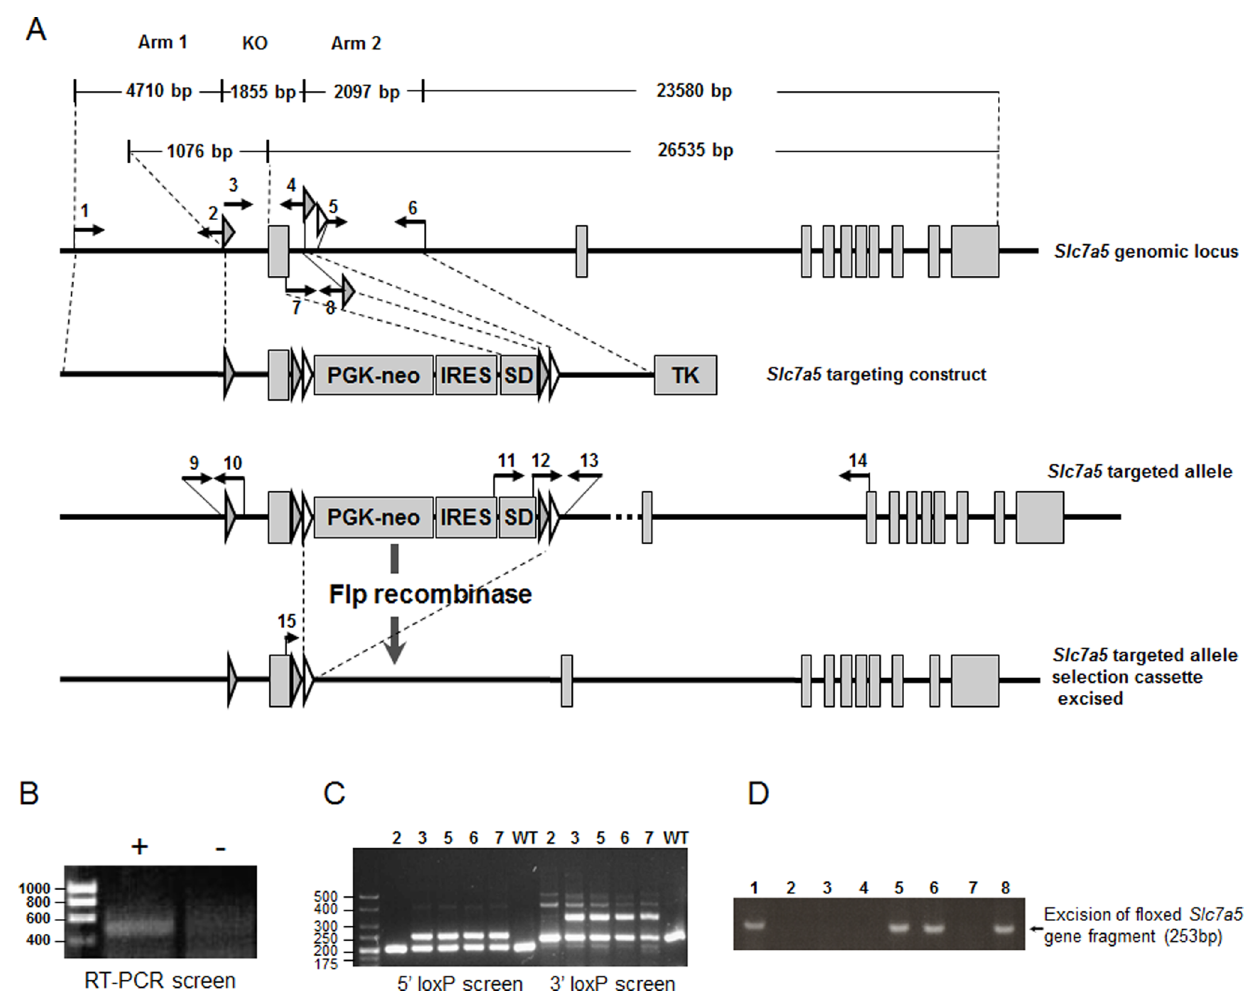
Figure 1. Slc7a5- Flox gene construct and mouse genotyping scheme. (A) Graphical representation of the Slc7a5 -Flox construct used to generate the chimera. Primer locations used for vector assembly and genotyping are indicated and primer sequences shown in Table 1. LoxP sites (grey-filled triangles), FRT sites (white-filled triangles), phosphoglucokinase (PGK) promoter-driven neomycin-resistance gene (PGK-neo) and thymidine kinase gene (TK) are shown. The splice donor (SD) was incorporated into the targeting construct to allow correct splicing of the transcript generated from the PGK promoter only if the targeting construct is inserted within an intron (see B). (B) to (D) Representative PCR genotyping results. (B) RT-PCR screen of RNA from mouse embryonic stem cells using 11–14 primer pair, a 500 bp product would indicate correct joining of the exonic sequence from the splice donor with exon3 of Slc7a5 . Gel shows RT-PCR for a positive ES cell population ( + ) or control cells (–). (C) Genotyping PCR for the 5 9 loxP site using DNA from C57Bl/6 (WT) or a mixed litter of wild-type (2) and heterozygous Slc7a5 Flox Neo ( + / 2 ) (3, 5, 6, 7) mice as a template resulted in either a product of 202 bp or products of 202 and 250 bp, respectively using the 9–10 primer pair. For 3 9 loxP site genotyping, PCR using primer pair 12–13 (note primer 12 is duplicated in SD) generated a 230 bp product from wild-type samples or products of 230 and 318 bp from heterozygotes. (D) PCR analysis of genomic DNA from a single mixed litter of heterozygous Slc7a5 -Flox (2,3,4,7) and Slc7a5 + / 2 (1,5,6,8) mice using the 9–13 primer pair which generates a product of 235 bp only with the recombined Slc7a5 gene lacking the 1855 bp floxed region (which includes exon1). doi:10.1371/journal.pone.0089547.g001 selection using neomycin and glanciclovir, respectively [17]. ES Animals cells were then screened by RT-PCR using primers with binding sites located in the IRES element in the SLC7A5 targeting construct and in exon3 of the Slc7a5 gene, which is located downstream of the vector insertion site (Figure 1A and 1B). ES cells that expressed the product of the IRES (and therefore harboured the transgene) were selected for implantation into mouse embryos. Chimeric mice which gave germline transmission were crossed with Flpe transgenic mice to remove the neomycin Genotyping of Mice by PCR selection cassette. aged $ 21 days or from pups sacrificed on date of birth. Genomic DNA was extracted from the biopsies using the DNeasy Blood and